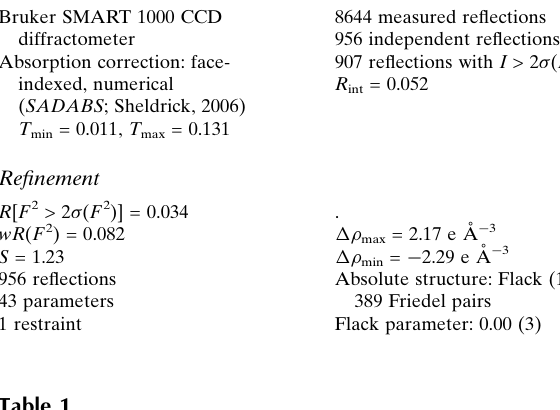
Selected geometric parameters (A˚ , (cid:3)